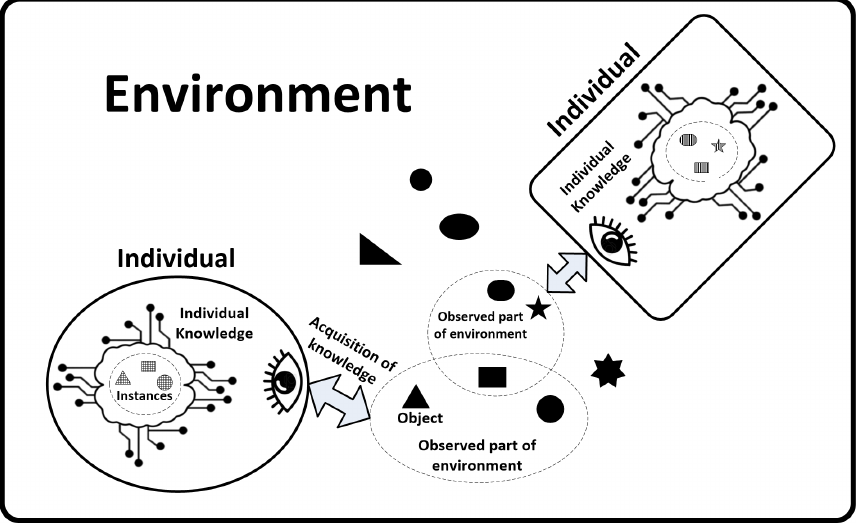
Figure 1. The environment with objects and perception of